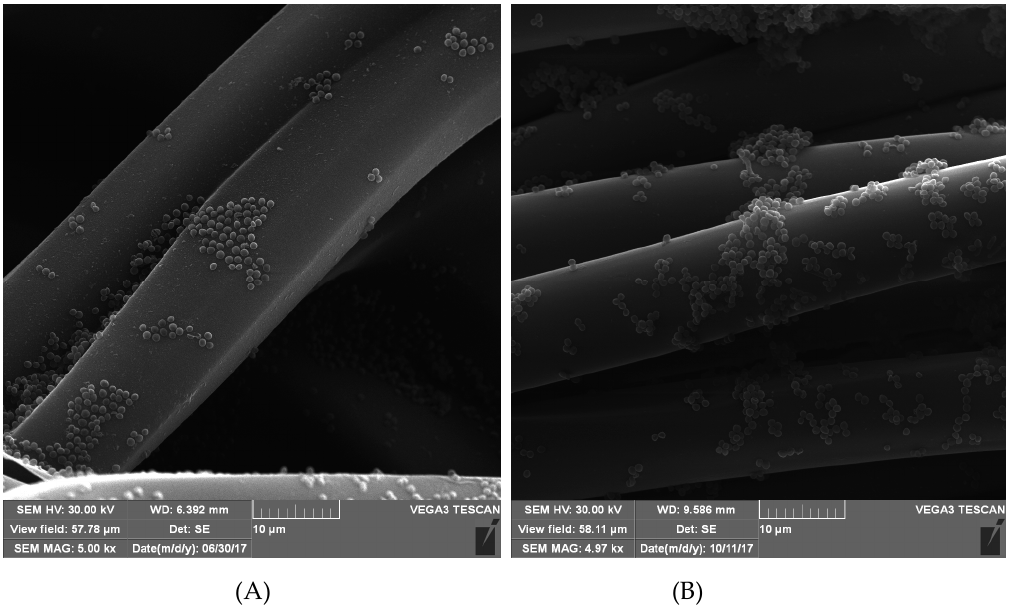
Figure 3. SEM photomicrographs of the Uni-Graft prosthesis surface ( A ) modified with AEBSF inhibitor and ( B ) unmodified, after incubation with Staphylococcus aureus cells